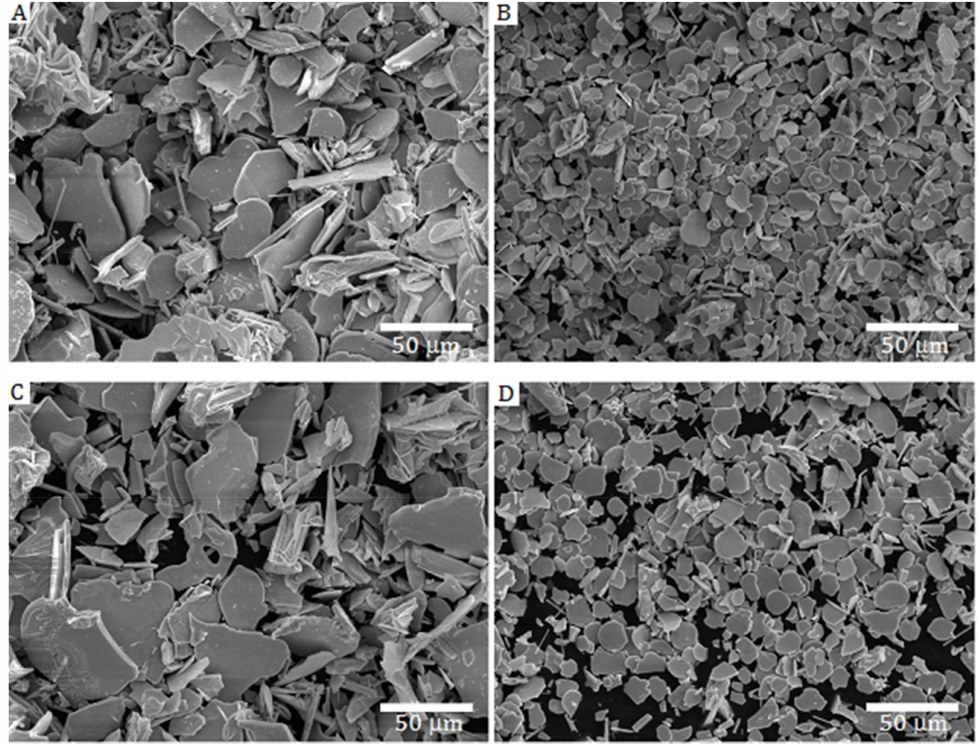
Figure 7. SEM images of BICUVOX (left) and BICUTIVOX (right) synthesized under the same conditions: ( A ) BICUVOX, 650 ◦ C/8 h, ( B ) BICUTIVOX, 650 ◦ C/8 h, ( C ) BICUVOX, 675 ◦ C/8 h, ( D ) BICUTIVOX, 675 ◦ C/8